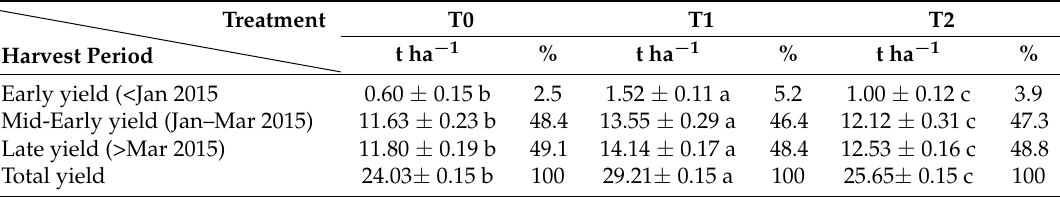
Table 2. Yield distribution (t ha −1 ) and percentage per treatment according to the cutting type used for the artichoke vegetative propagation.